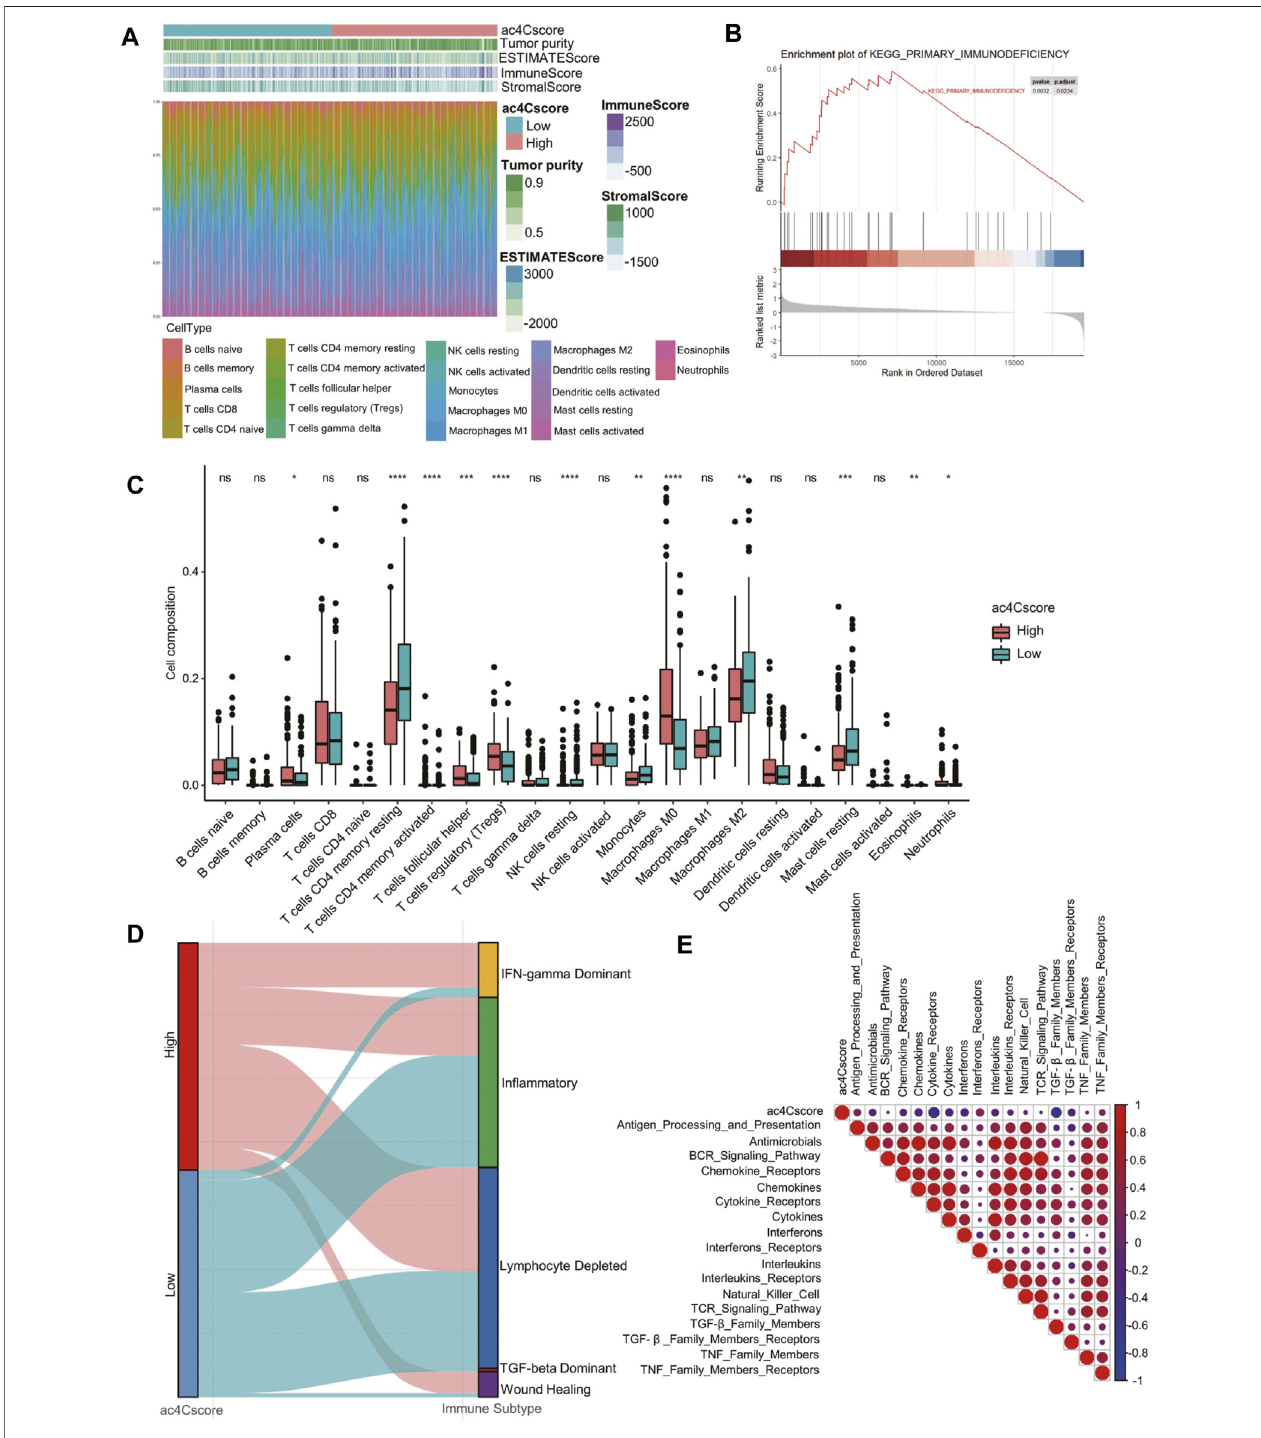
FIGURE 5 | The landscape of the TME and biological characteristics in the ac4Cscore groups. (A) The calculated values of the TME score and proportion of immunecellin fi ltration ofeach patient. (B) GSEA plotshowstheupregulatedgenesintheac4Cscorehigh groupenrichedintheprimaryimmunode fi ciencypathway. (C) The distribution of 22 immune cell types in different ac4Cscore groups. Wilcoxon test is used for statistical analysis. * p < 0.05, ** p < 0.01, *** p < 0.001, **** p < 0.0001 and ns indicates not signi fi cant. (D) Alluvial diagram depicts the attribution of immune subtypes in the ac4Cscore groups. (E) Correlation plot displaying the relationships between ac4Cscore and immune signatures. Pearson correlation coef fi cient is used for analysis. Size and colors of circle indicates the coef fi cient.